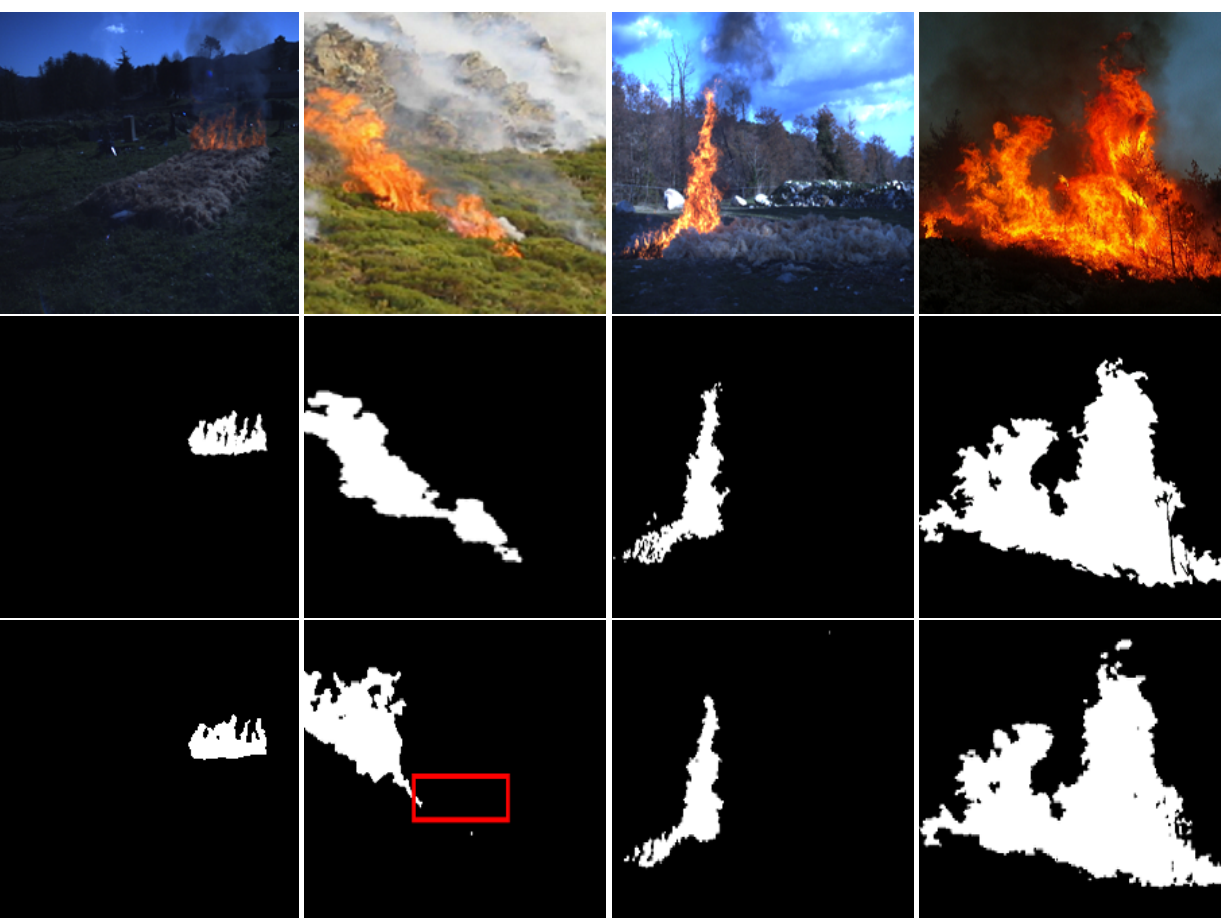
Figure 8. Results of MedT. From ( top ) to ( bottom ): RGB images, their corresponding mask, and the predicted images of